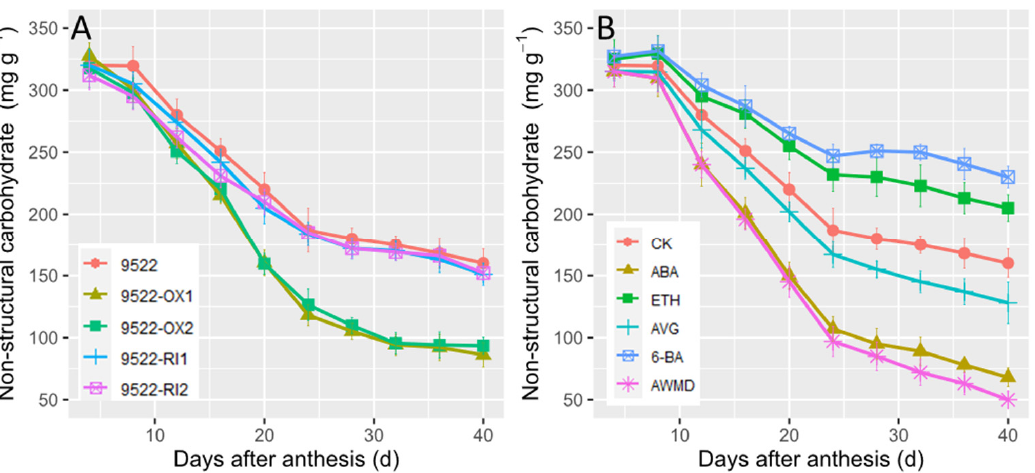
Figure 7. Changes in contents of nonstructural carbohydrates (NSCs) in the stems of wildtype and transgenic lines ( A ), and application of exogenous phytohormone/alternate wetting and under moderate drying (AWMD) irrigation ( B ) during grain filling stage. Symbols and significance levels are as described in Figure 1.